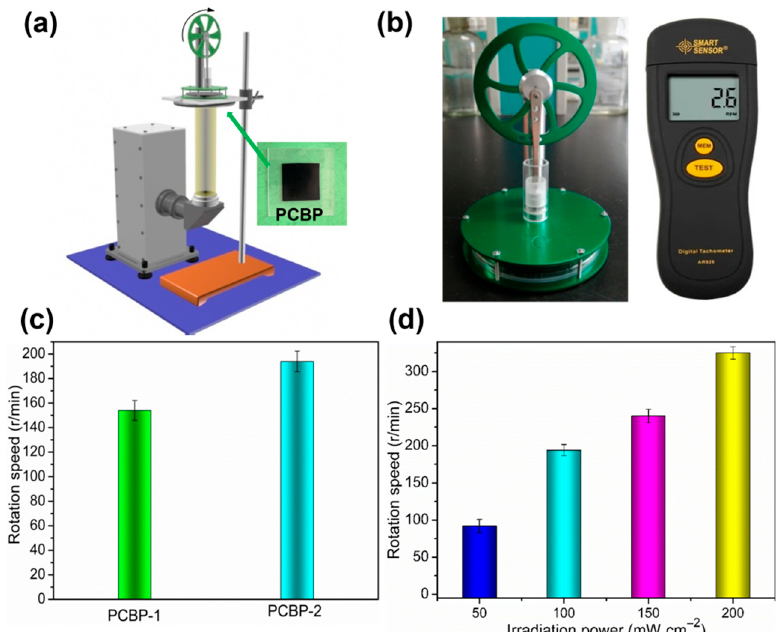
Figure 8. ( a ) Schematic of the setup for photothermal drive Stirling engine motion experiment; ( b ) Stirling engine and non-contact speedometer; ( c ) rotation speed of Stirling engine in the presence of PCBP-1 and PCBP-2 under 100 mW cm − 2 solar light irradiation; ( d ) rotational speed of the Stirling engine in the presence of PCBP-2 under different intensities of irradiation.